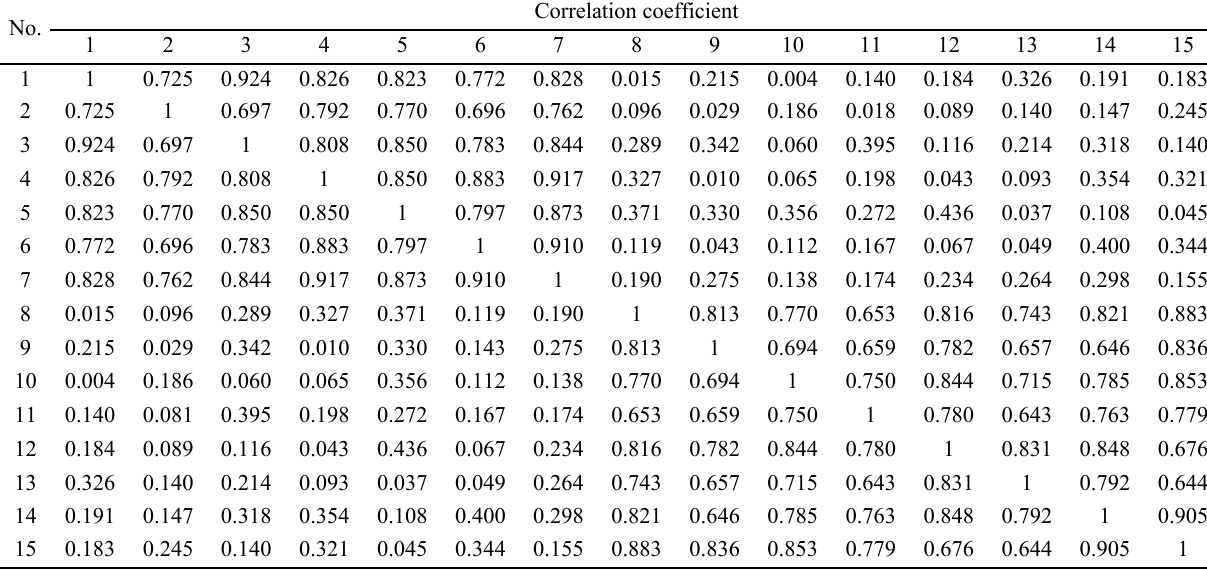
Table 2 Correlation coefficient among the 15